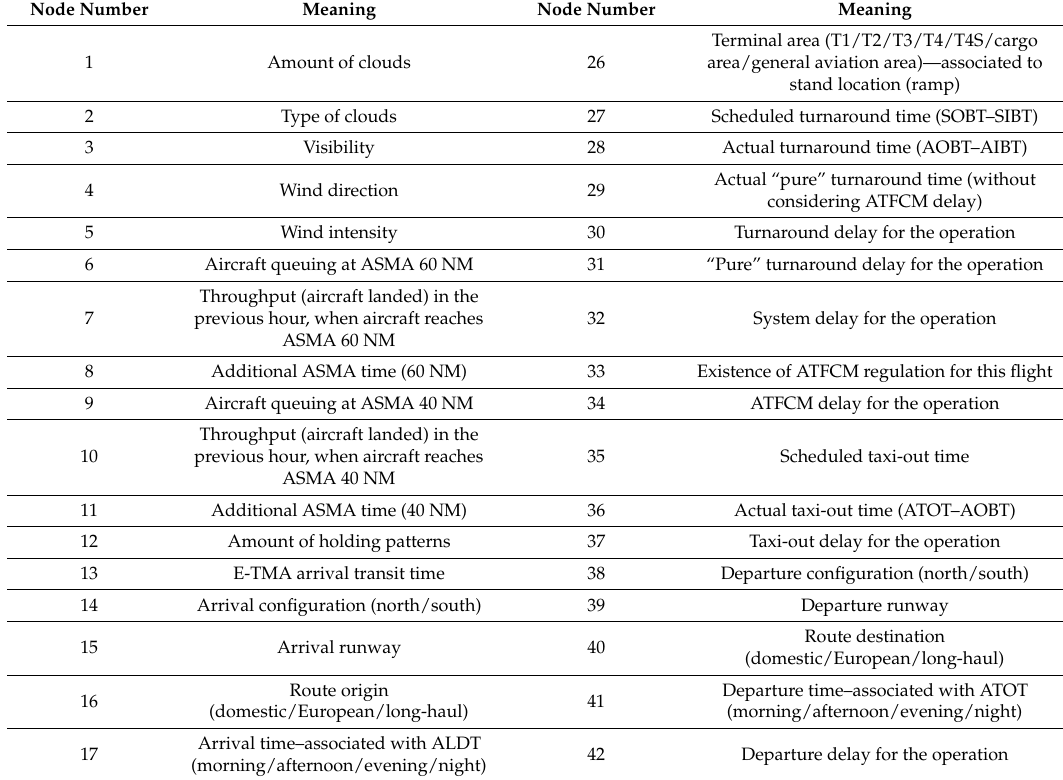
Table 4. List of variables represented in the causal model (nodes at the